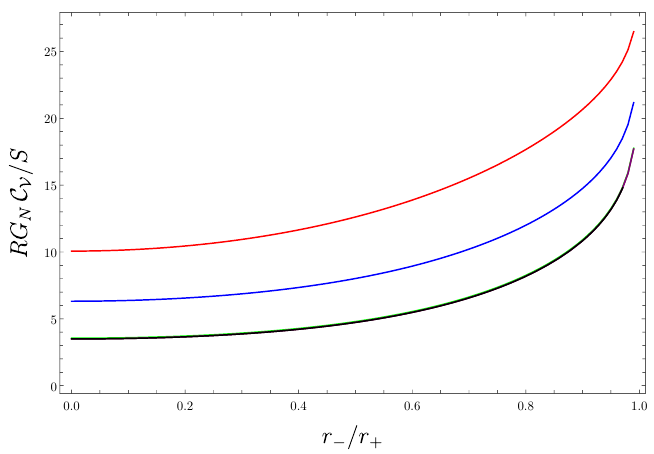
Figure 15. A plot of the complexity of formation within the CV conjecture for five dimensional, spherical ( k = +1) black holes. We have normalized the complexity of formation by the entropy and the curves shown correspond to r + /‘ = 1 / 2 , 1 , 10 , 50 , 100 in order from top to bottom. The last three curves are visually indistinguishable. Imposed on the plot in a black curve is the complexity of formation for the planar k = 0 charged black hole. This curve coincides with the last three plots for the spherical black